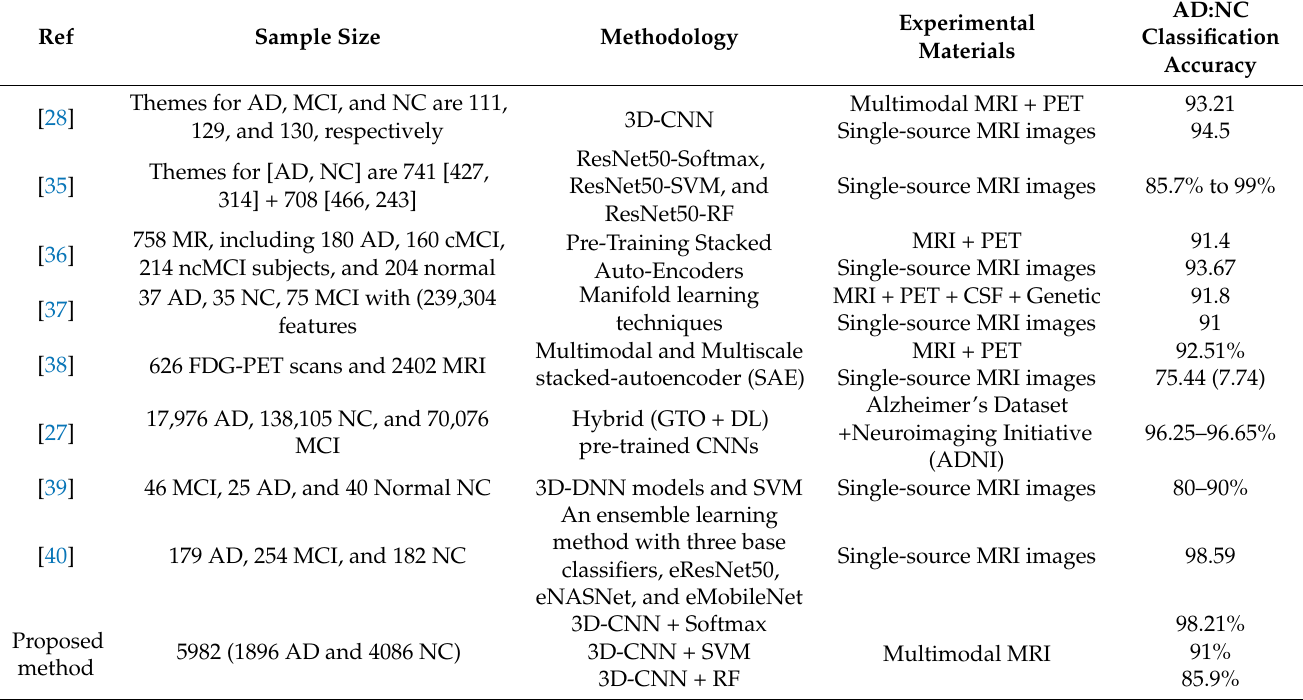
Table 8. The performance of MULTforAD in comparison with competitors.